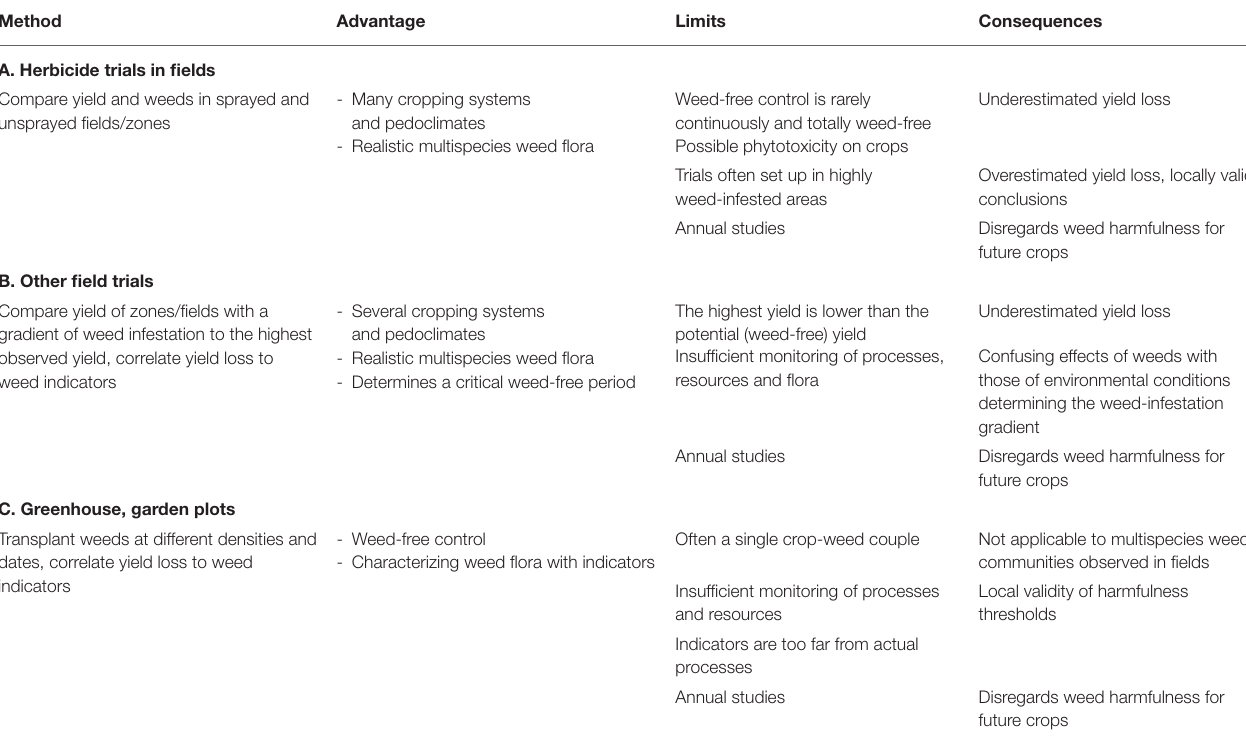
TABLE 1 | Critical summary of methods studying the effects of weeds on crop yield loss based literature